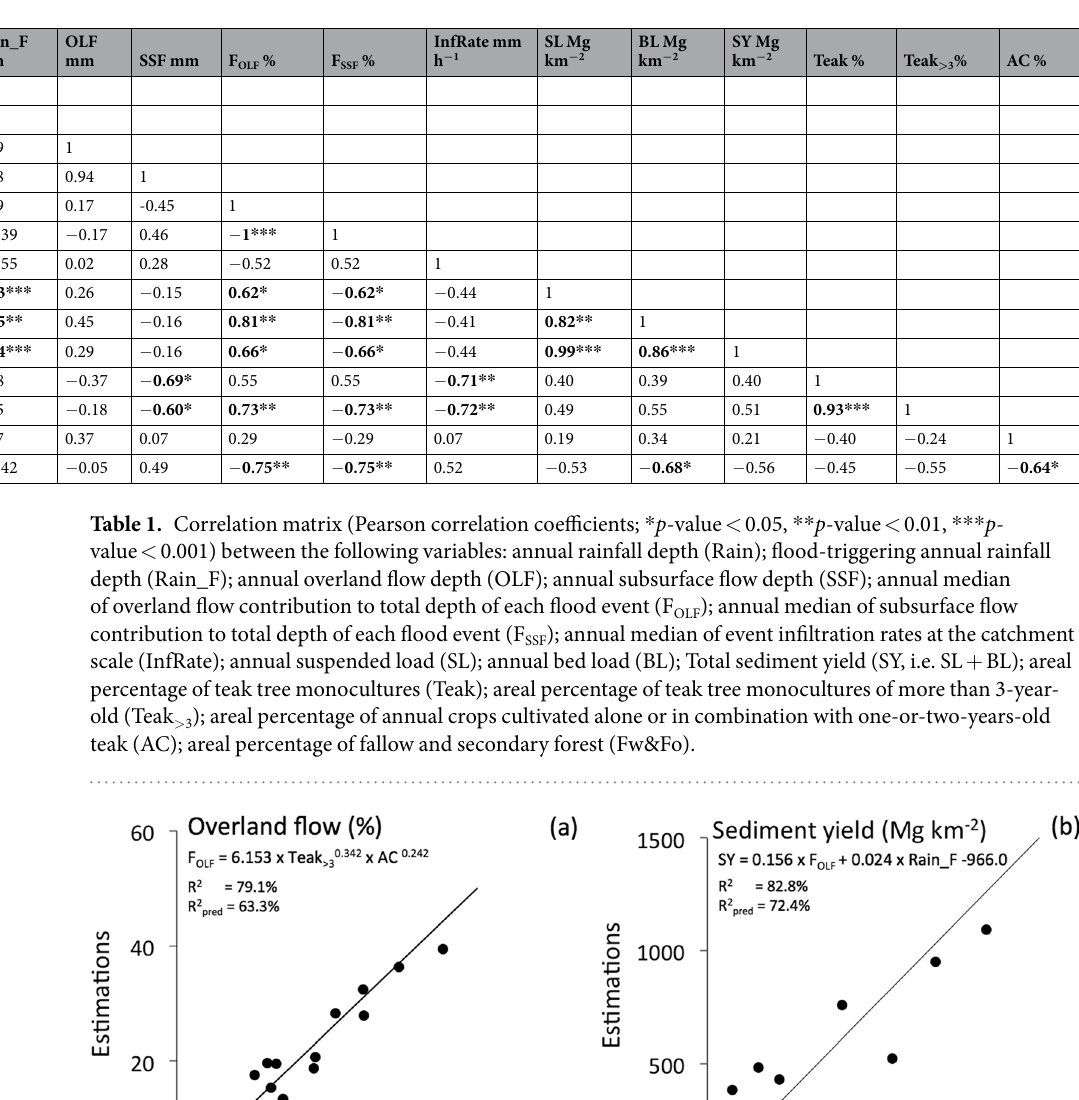
relation was observed between the areal percentage of Fw&Fo and soil losses. However, it was significant for BL only ( p -value < 0.05) (Table 1). Multiple log-linear and linear regressions were conducted to identify explanatory variables that best predicted the inter-annual variations of F OLF and SY. All the variables listed in Table 1 were considered in this analysis. and F OLF for SY (Fig. 4b). While the regression model predicting SY was linear, a stronger log-linear relationship